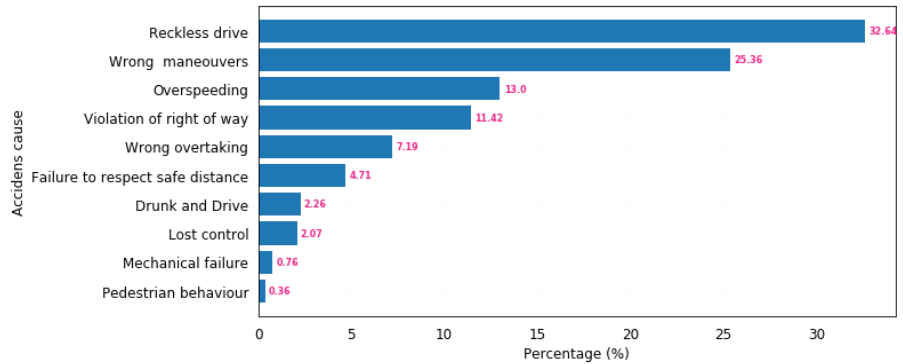
Figure 1. Number of confirmed road accident cases in Rwanda by causing factor